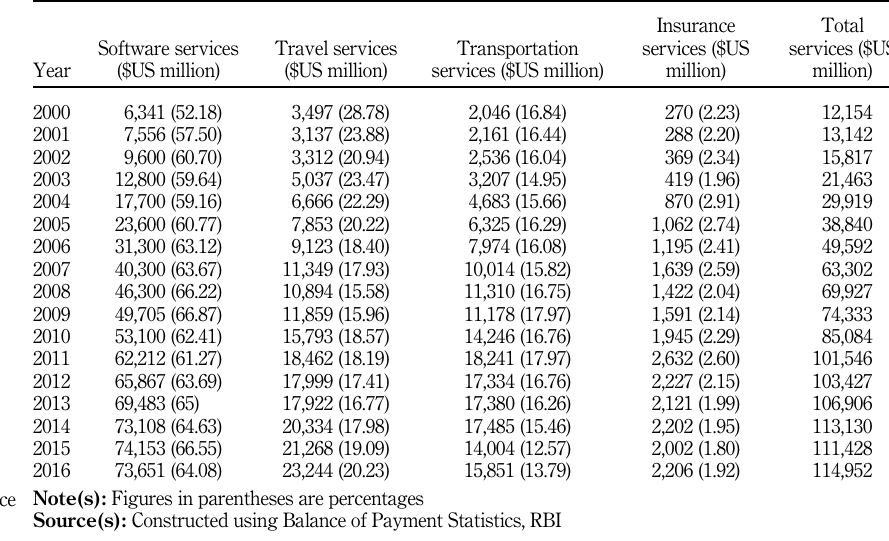
Table 6. Composition of